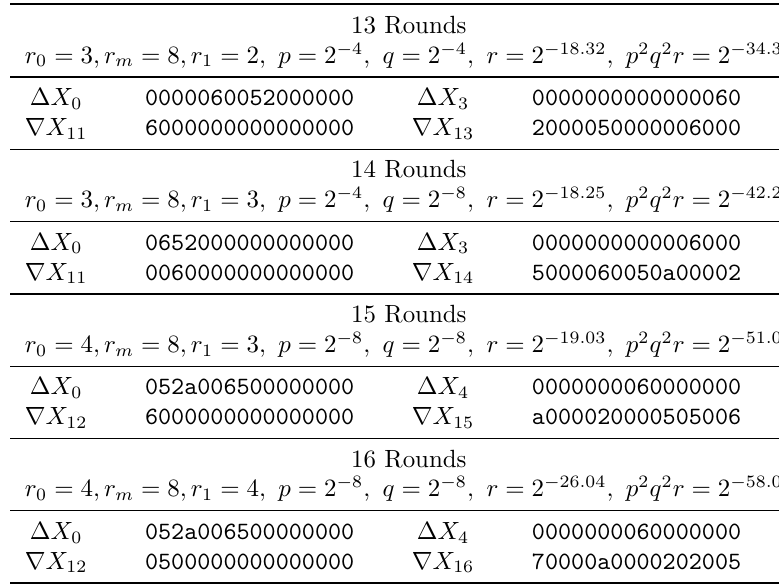
Table 12: Specification of Sandwich Distinguishers for TWINE